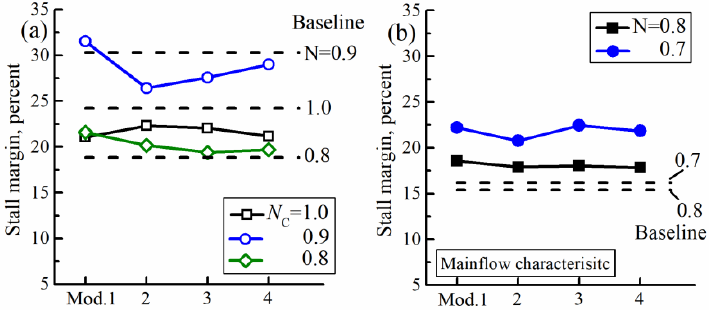
Figure 12. The influence of modifications of rotor R2 and stator S1 on the stall margin in single flow-path mode ( a ) and double flow-path mode ( b ).